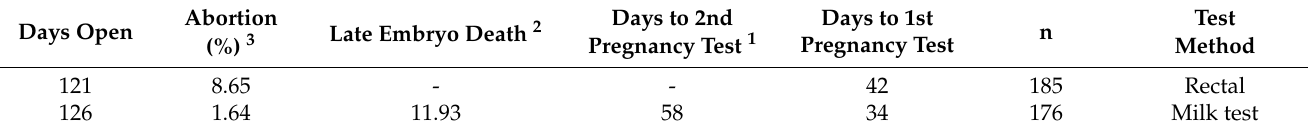
Table 1. First positive pregnancy test in both treatment groups.